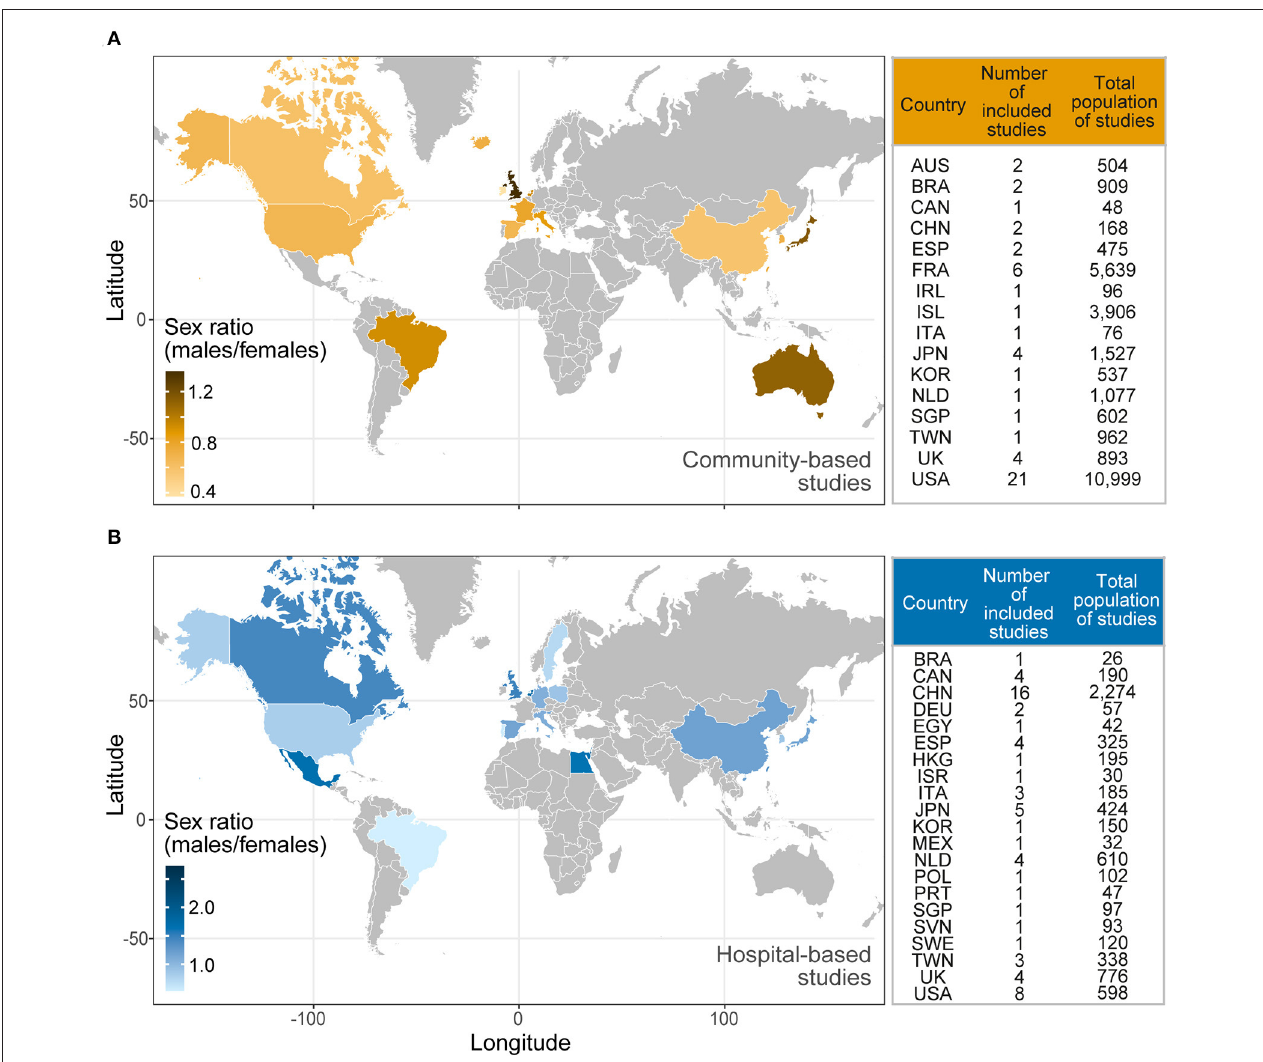
FIGURE 3 | Sex ratio of SVD studies across the world. Colored world maps representing the mean sex ratio of the total number of participants of (A) community-based and (B) hospital-based studies. Darker shades in the color gradient correspond to higher sex ratios (i.e., more males than females). The tables on the right specify the country of recruited participants, the number of included studies and the total population of included studies per study type. Neither multicentre nor mixed studies were represented in these maps. AUS, Australia; BRA, Brazil; CAN, Canada; CHN, China; DEU, Germany; EGY, Egypt; ESP, Spain; FRA, France; HKG, Hong Kong; IRL, Ireland; ISR, Israel; ITA, Italy; JPN, Japan; KOR, Korea; MEX, Mexico; NLD, The Netherlands; POL, Poland; PRT, Portugal; SGP, Singapore; SVN, Slovenia; SWE, Sweden; TWN, Taiwan; UK, United Kingdom; USA, The United States of